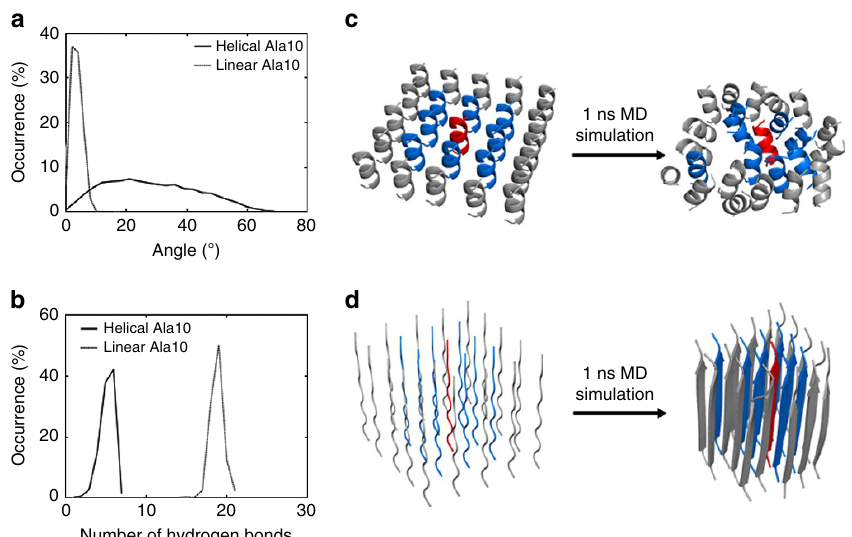
Figure 2 | Molecular dynamics simulations of monolayers of oligoalanine peptides attached covalently to a surface. 5 (cid:3) 5 monolayer of 10-mer oligoalanine (Ala10), modeled as ( c ) an a -helical or ( d ) a linear conformation. Each model of the monolayer was simulated for 1ns and further analysis was performed on the central peptide (red) relative to its eight neighbors (blue). Also shown is the distribution of the: ( a ) angle of the central peptide intra- peptide hydrogen bonds; ( b ) number of inter-peptide hydrogen bonds between the central peptide and neighboring